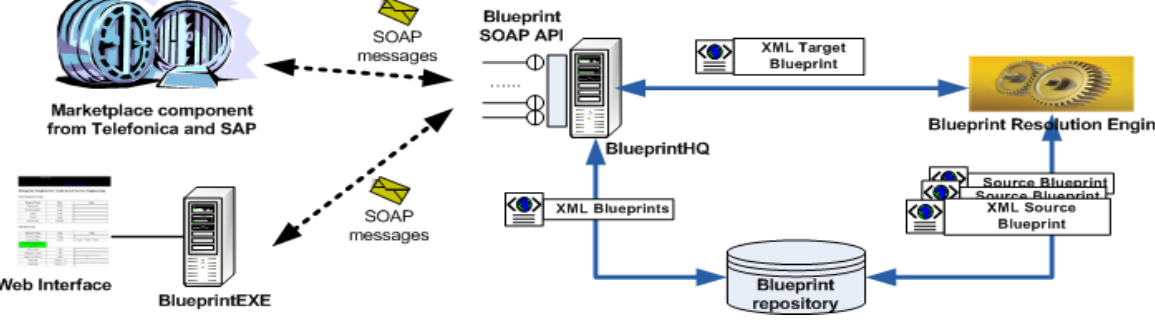
Figure 11. Blueprint Prototype Architecture.